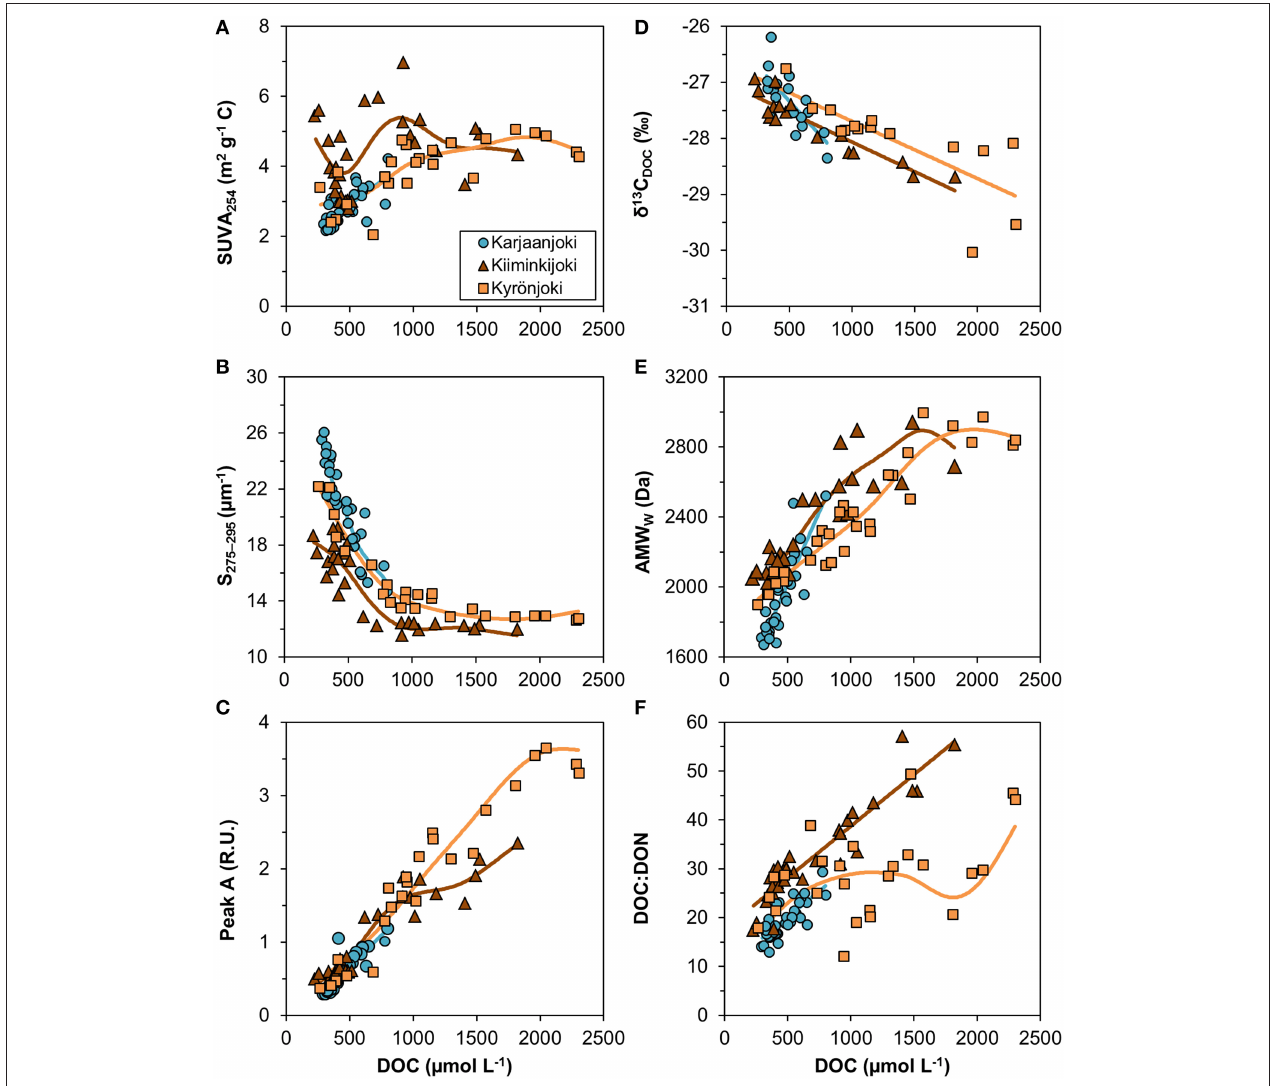
FIGURE 4 | Relationships between DOM quality variables and DOC concentration. (A) SUVA 254 = DOC-specific UV absorbance at 254nm, (B) S 275 − 295 = slope of CDOM absorbance between 275 and 275nm, (C) peak A = DOM fluorescence in ex/em range 260/400–460nm, (D) δ 13 C DOC = stable carbon isotope ratio of DOC, (E) AMW W = weight-averaged molecular weight, and (F) DOC:DON ratio (mol/mol). Generalized additive models (GAM) are fitted to data (solid lines). The GAM relationships are shown as linear regressions if the non-linear component was not significant ( Table 2